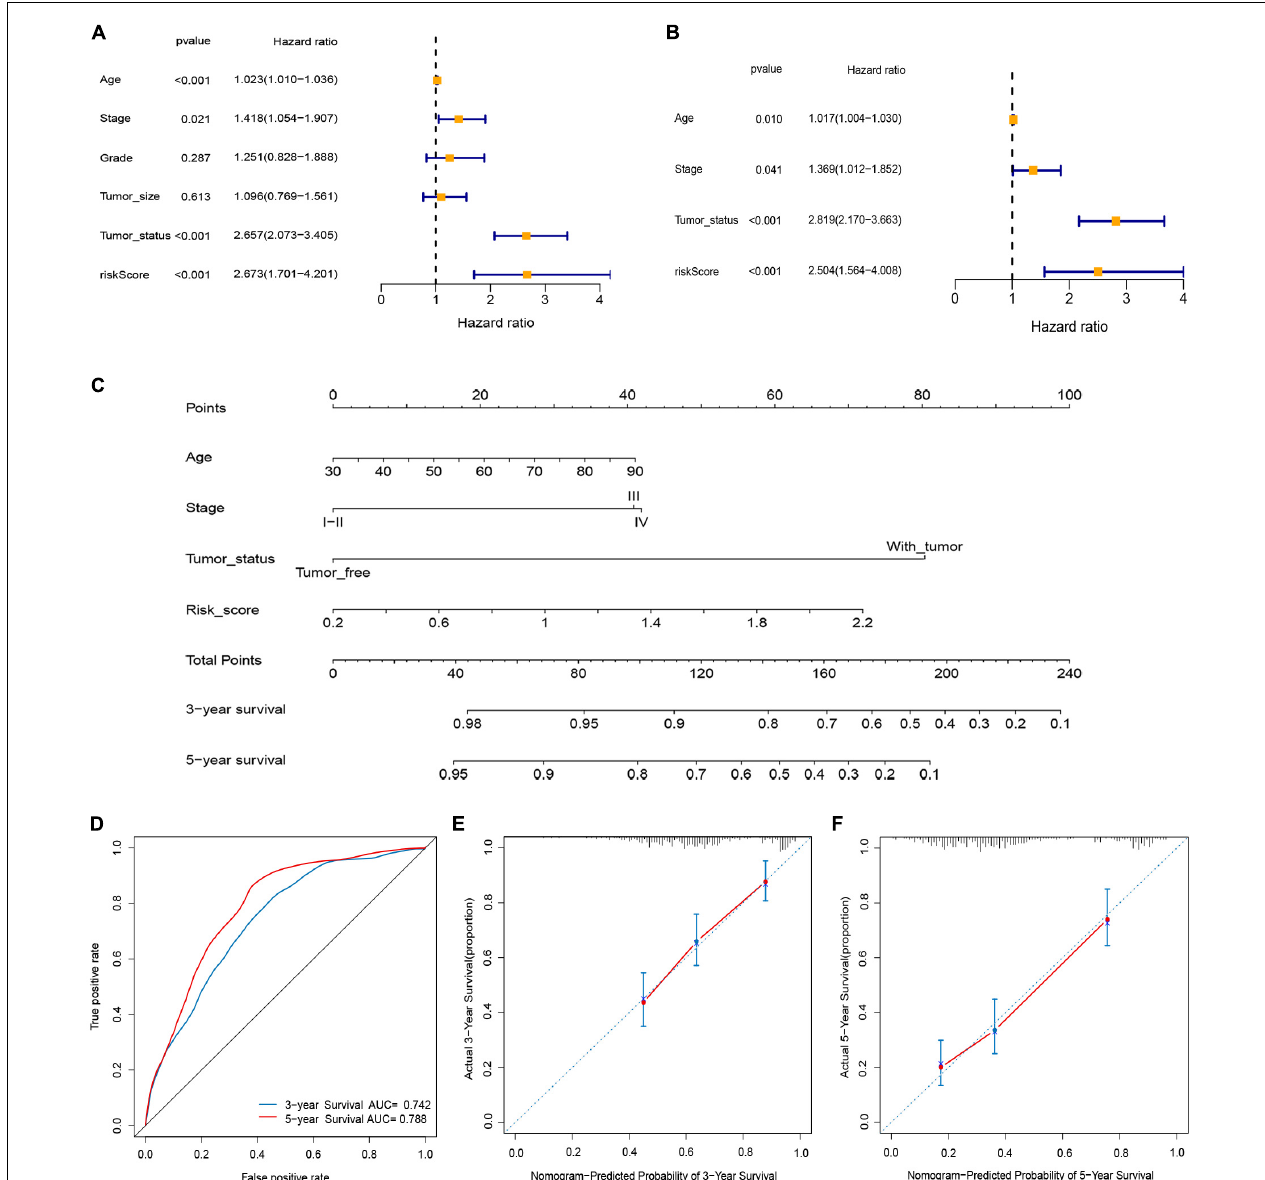
FIGURE 6 | Construction and validation of nomogram. (A) Univariate Cox analysis. (B) Multivariate Cox analysis. (C) Nomogram for predicting 3- and 5-year overall survival of OC patients. (D) Time-dependent ROCs for 3- and 5-year OS of the nomogram. (E,F) Calibration curves of the nomogram prediction of 3-and 5-year OS of patients with